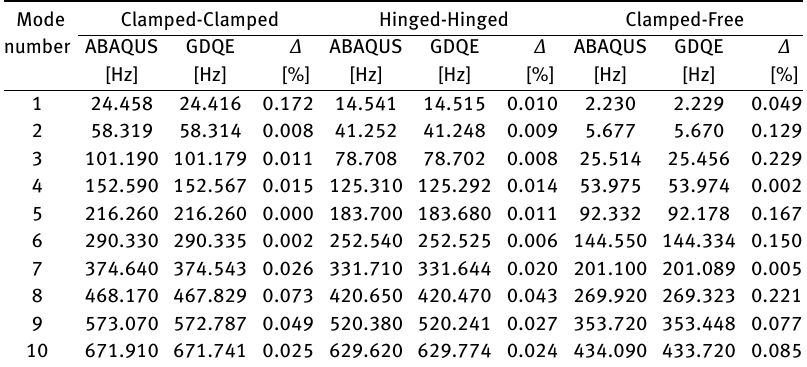
Table 5: Comparison between the ABAQUS solution and the current in-house code values for the first 10 natural frequencies of undamaged three-stepped parabolic